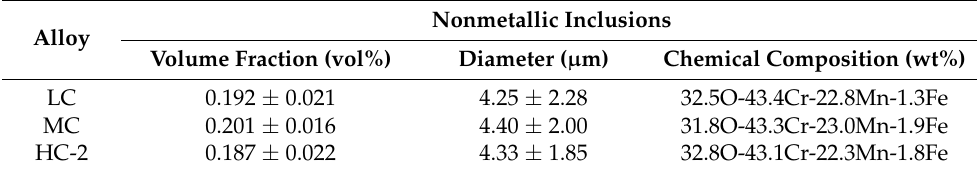
Table 2. NMI analysis results: volume fraction, size, and chemical composition.